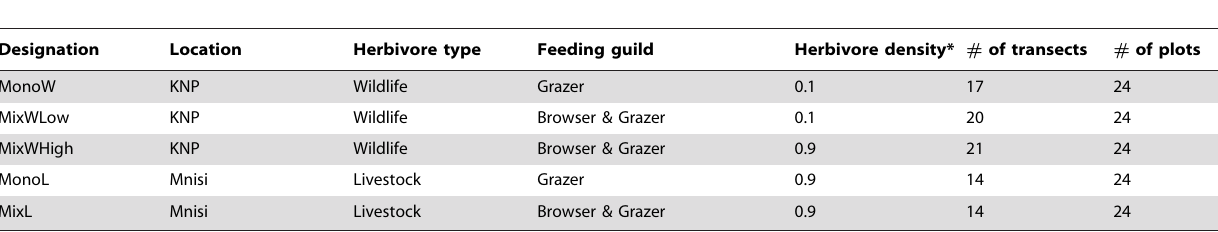
Table 1. Study sites and their location, herbivore assemblage type, feeding guilds and densities (in tropical livestock unit TLU ha 2 1